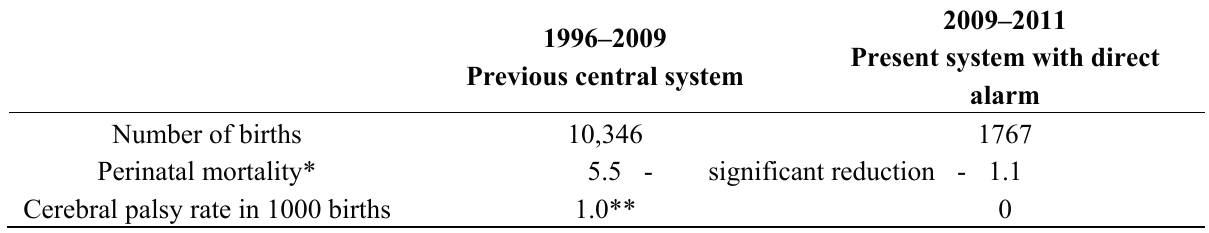
Table 3. Improved clinical results compared to the previous computer system [18].